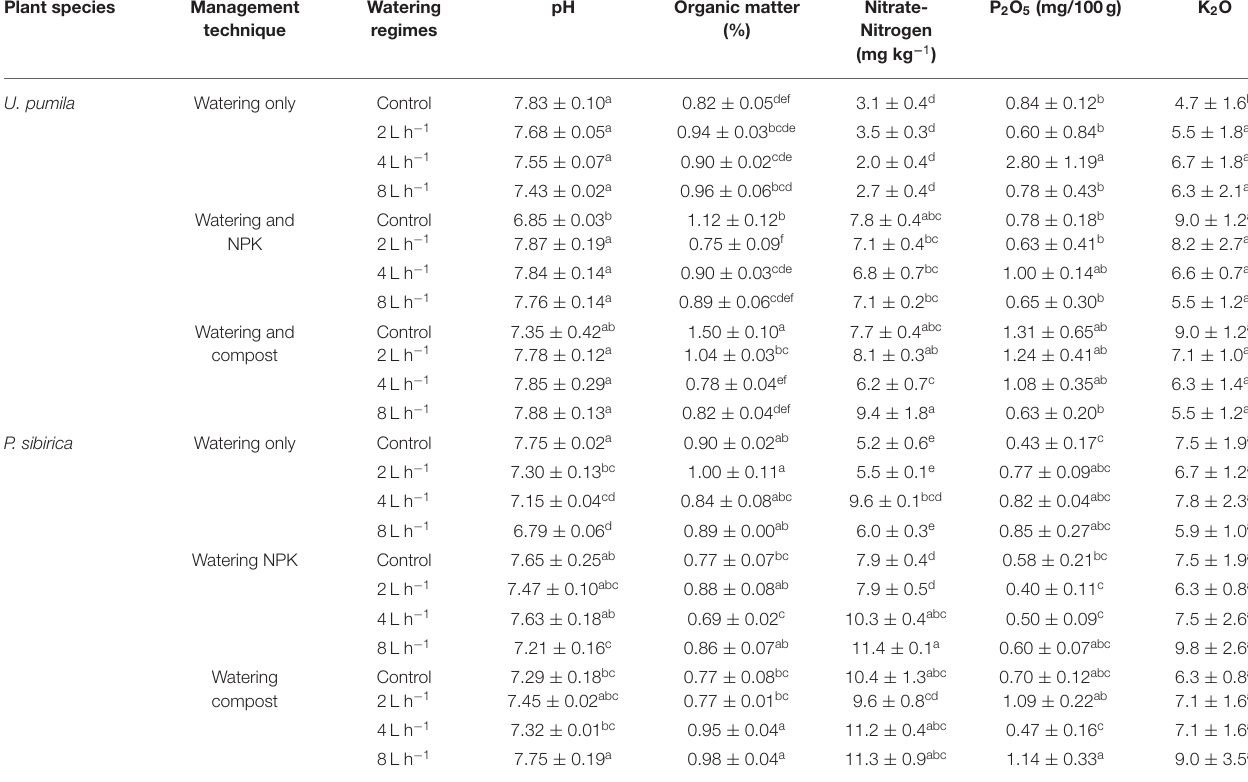
TABLE 2 | Soil chemical properties for different management techniques and watering regimes for Ulmus pumila and Populus sibirica . Plant